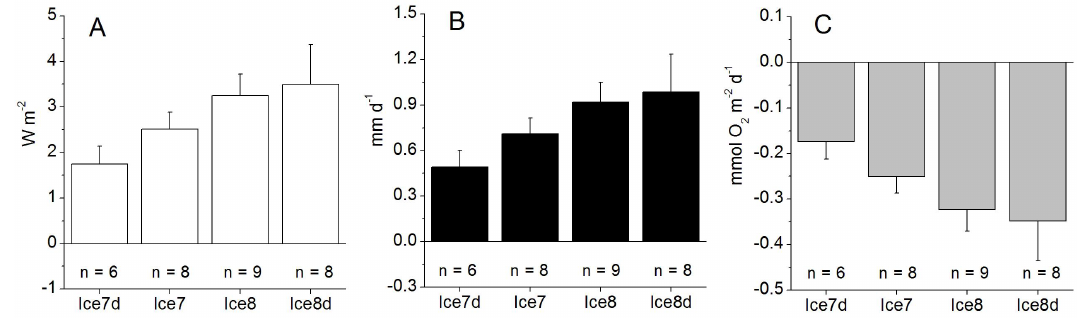
Fig. 8. (A) shows the averaged heat fluxes for periods with well-developed turbulence under the ice-water interface. The maximum potential ice melt rate derived from the heat flux is shown in (B) and the maximum O 2 flux calculated from this melt rate is shown in (C) . The n represents the number of 0.25h measuring periods and error bars represent standard errors.